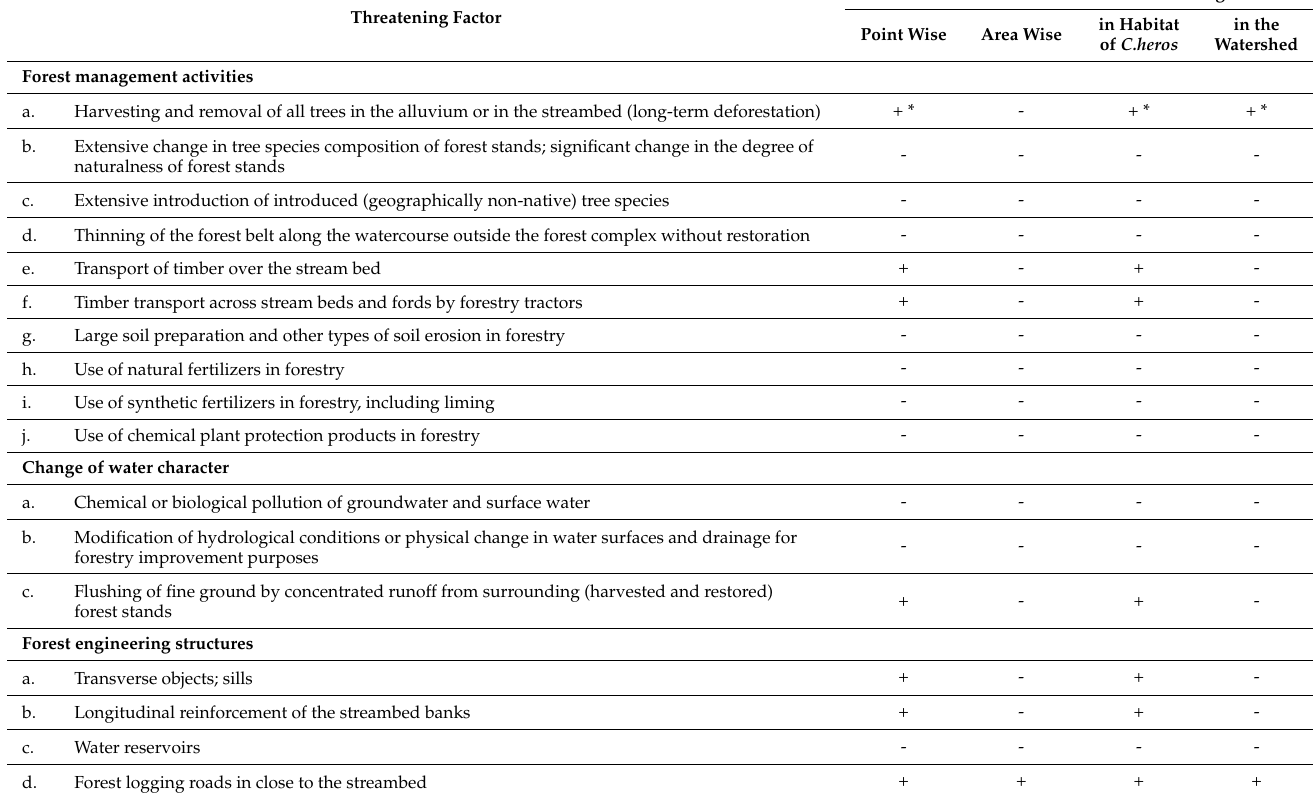
Table 4. Overview of potential and threatening factors or effects influencing the population of C. heros in Chˇriby hills. Threatening Factor